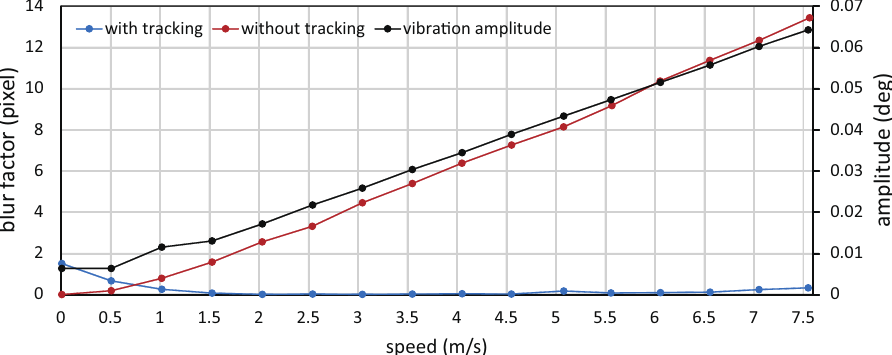
Figure 17. Blur indexes λ dot for a circle-dot pattern and the vibration amplitude of resonant mirror when video shooting with actuator